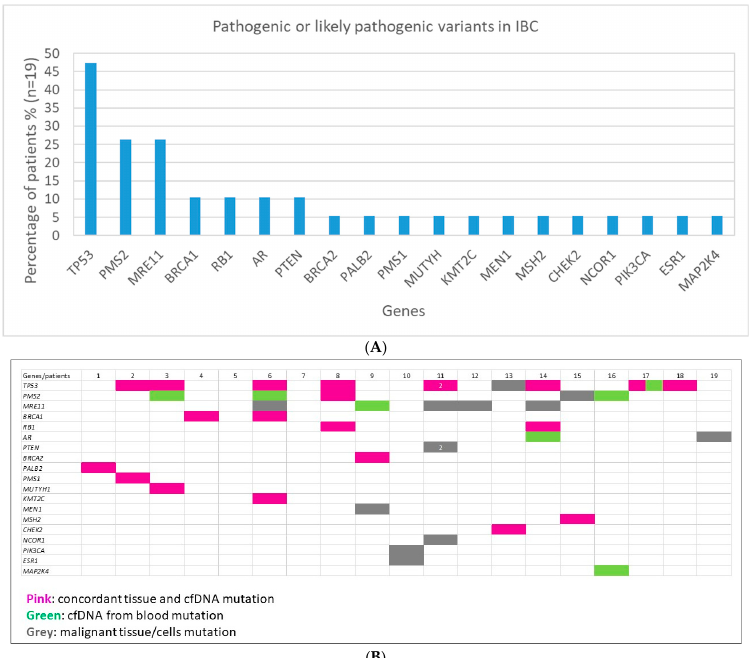
Figure 1. Genes with pathogenic or likely pathogenic variants in IBC. Genes with pathogenic or likely pathogenic variants in inflammatory breast cancer (IBC) patients ( n = 19) are shown. ( A ) Percentage of IBC patients with pathogenic or likely pathogenic variants in the genes indicated. ( B ) Pathogenic or likely pathogenic variants detected in both tissue and cfDNA (in pink), only in cfDNA (in